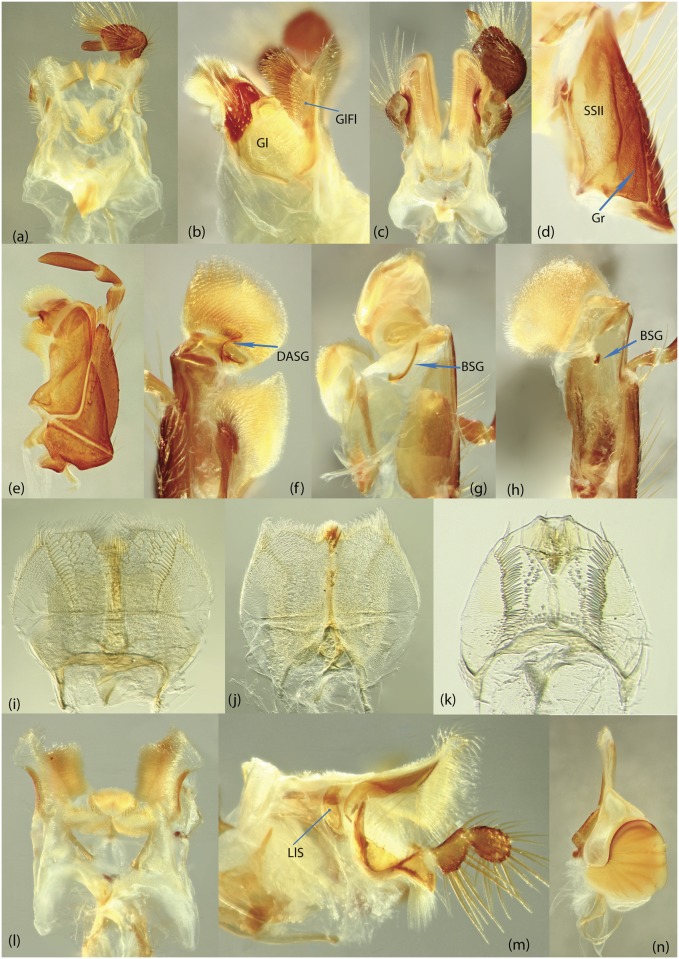
Mouthparts of Scarabaeinae.a,e,n, Scarabaeus aesculapius; b, Anachalcos convexus; c, Streblopus opatroides; d,f, Chalcocopris hesperus; h, Heliocopris sp; i, Copris sp.; j, Coptodactyla nitida; k, Zonocopris gibbicollis; l, Metacatharsius sp.; m, Eurysternus hamaticollis; a,c, hypopharynx and glossae, dorsal view, left maxillary palpus removed; b, hypopharynx and glossae, left lateral view, left maxillary palpus removed; d, left maxilla ventral view, stipital sclerite II; f, left maxilla dorsal view, dorsal articular sclerite of galea arrowed; g,h, right maxilla, dorsal view, sclerite of lacinia removed, basal sclerite of galea arrowed; i-k, epipharynx, ventral view; l, hypopharynx and glossae, dorsal view, both maxillary palpus removed; m, hypopharynx and glossae, right lateral view. n, right mandible, left lateral view.